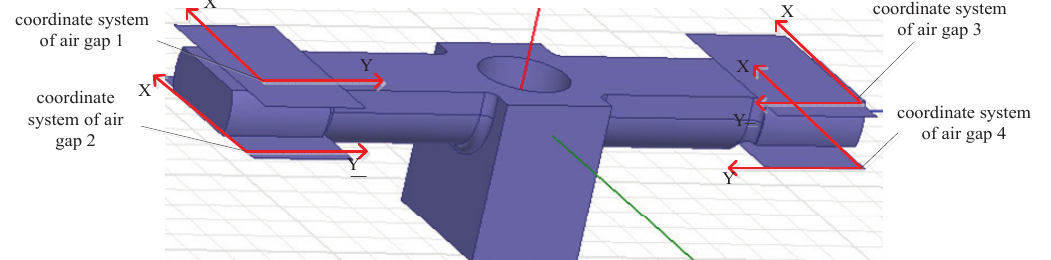
Figure 3. Rectangular coordinate systems at the air gaps.